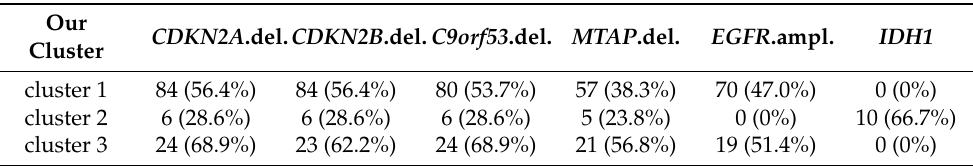
Table 6. Distribution of genetic variant signatures for the identified clusters.